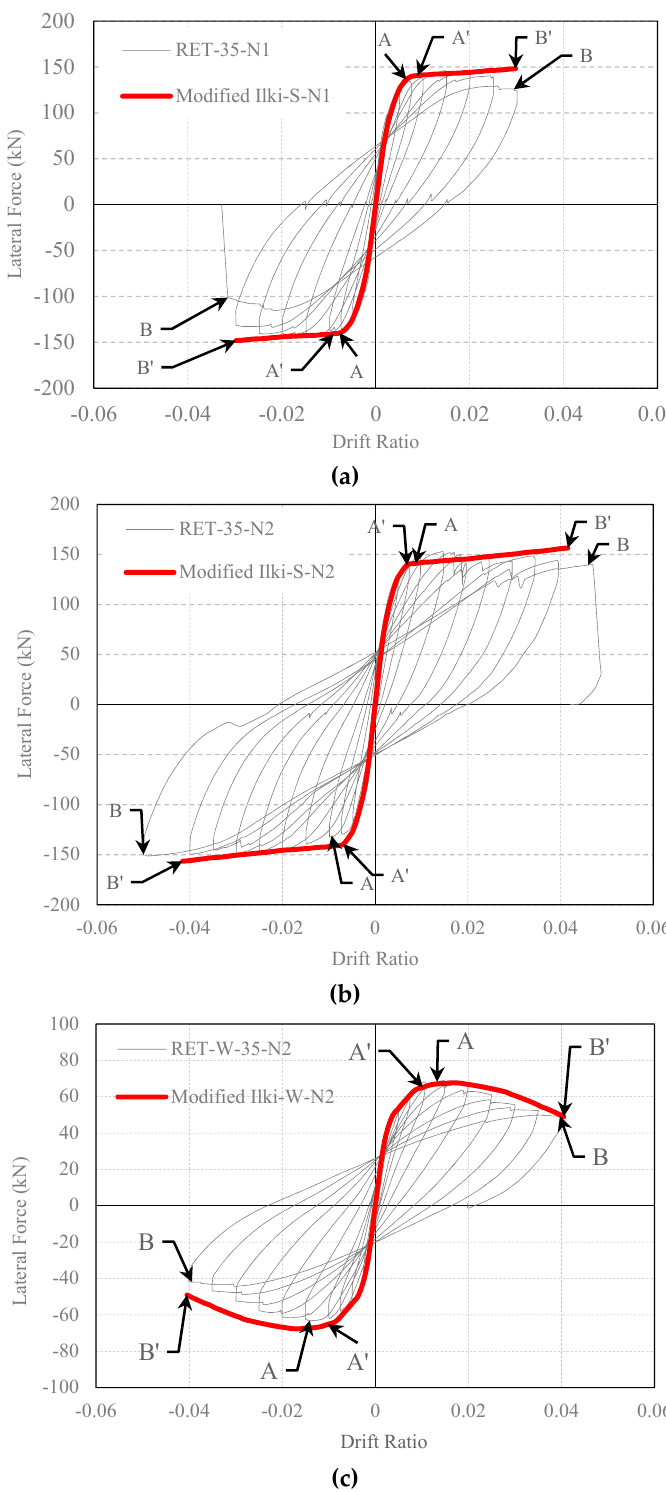
Figure 14. Comparison of experimental and analytical lateral load-drift relationships (confined concrete strength and strain capacity are obtained by using modified equations): ( a ) RET-35-N1, ( b ) RET-35-N2 and ( c ) RET-W-35-N2.